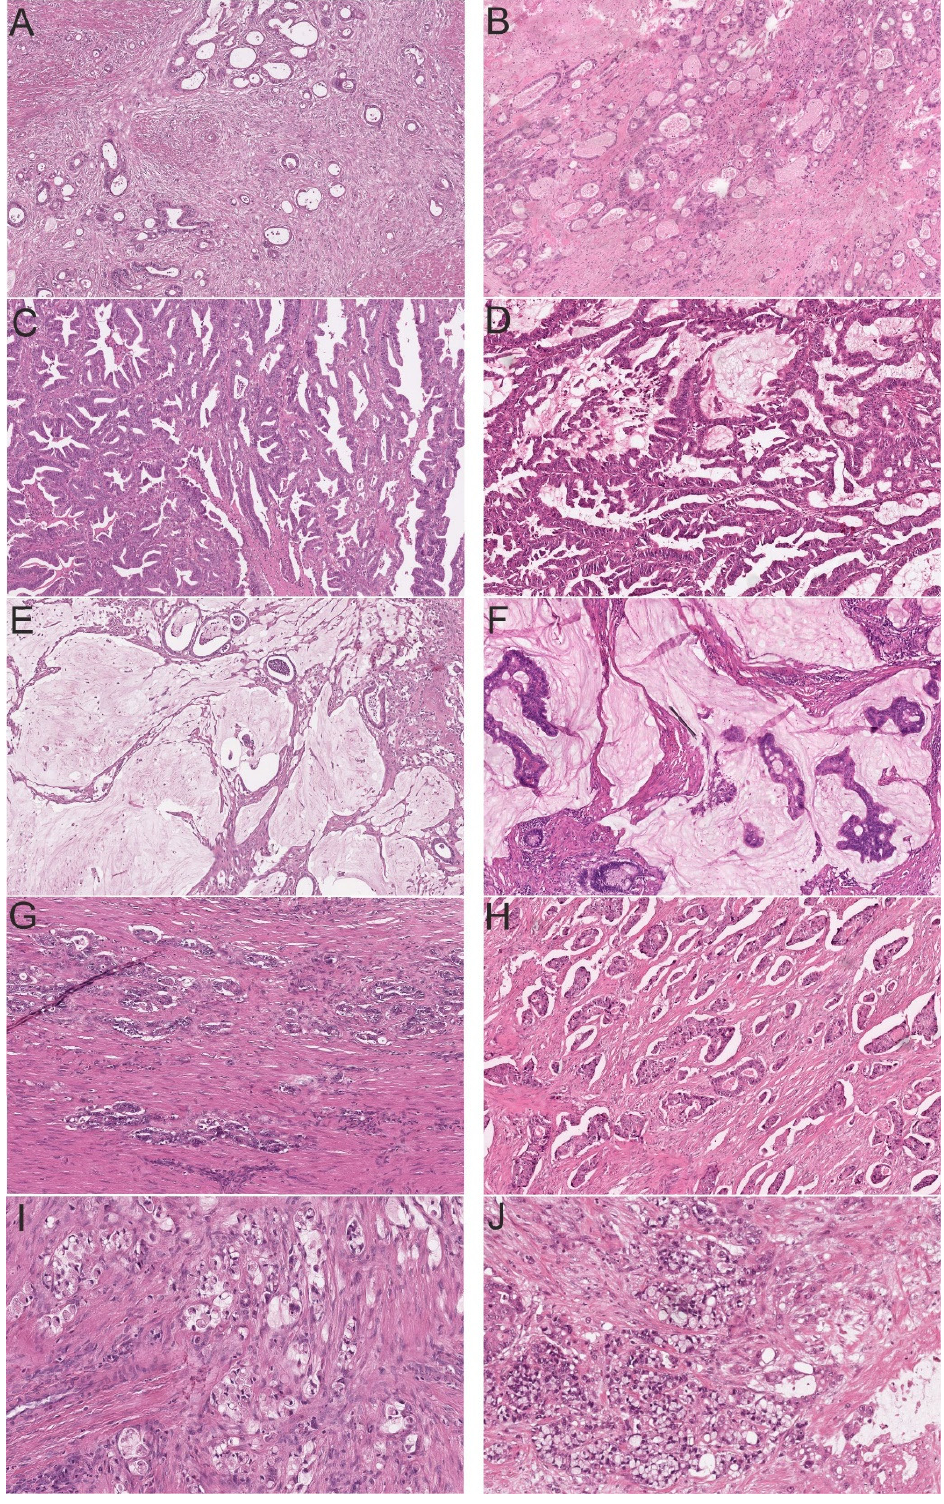
Figure 3. Feline intestinal carcinomas ( left ) closely resemble human WHO subtypes ( right ) (H&E). ( A ) Feline colonic adenocarcinoma not otherwise specified (ANOS, 8×); ( B ) Human colonic ANOS (8×); ( C ) Feline colonic serrated adenocarcinoma (SAC, 8×); ( D ) Human colonic SAC (8×); ( E ) Feline small intestinal mucinous adenocarcinoma (MAC, 8×); ( F ) Human colonic MAC (8×); ( G ) Feline small intestinal micropapillary carcinoma (MPC, 8×); ( H ) Human colonic MPC (8×); ( I ) Feline colonic signet-ring cell carcinoma (SRCC, 20×); and ( J ) Human colonic SRCC (20×).